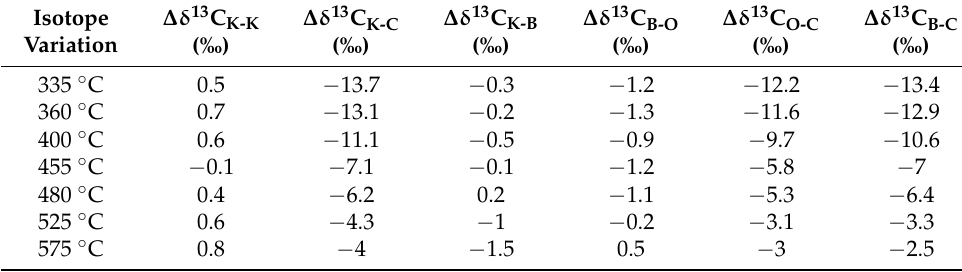
Table 4. The changing values of carbon isotope in different reaction